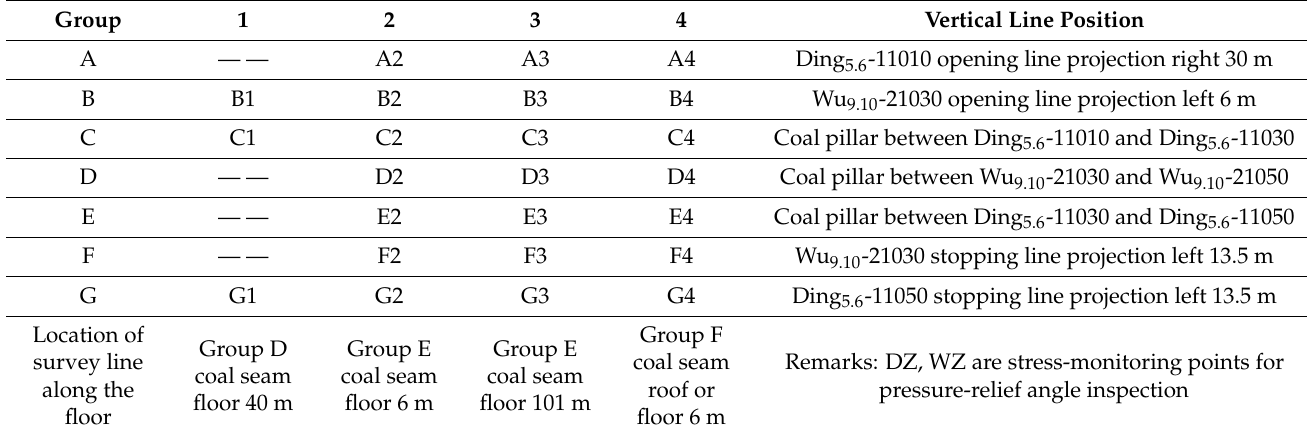
Table 1. Description table of arrangement of the stress-monitoring